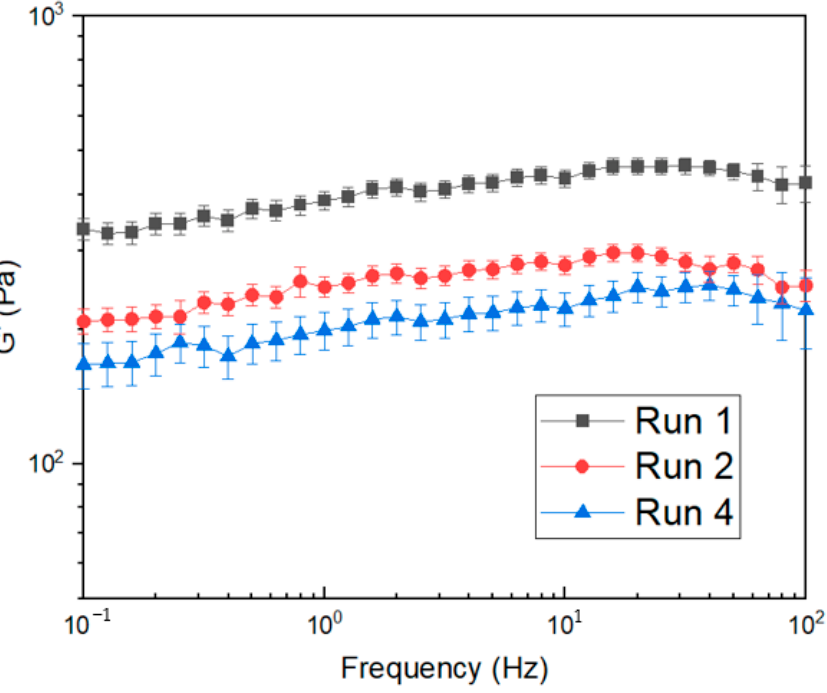
Figure 6. The changes in gel strength in Run 1, Run 2, and Run 4 SSAPs.